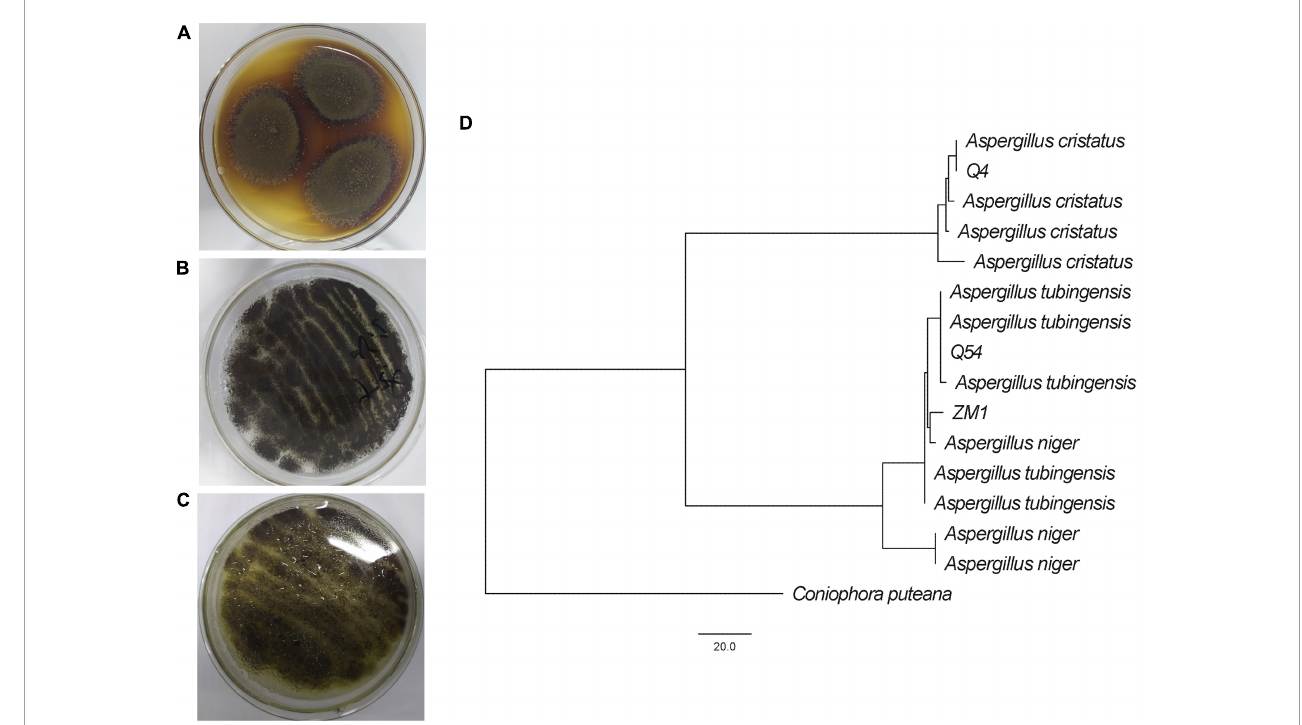
FIGURE1 Identification of A. cristatus (Q4) (A) , A. tubingensis (Q54) (B) , and A. niger (ZM1) (C) , including colony morphology on PDA plates and molecular phylogenetic analysis (D) .